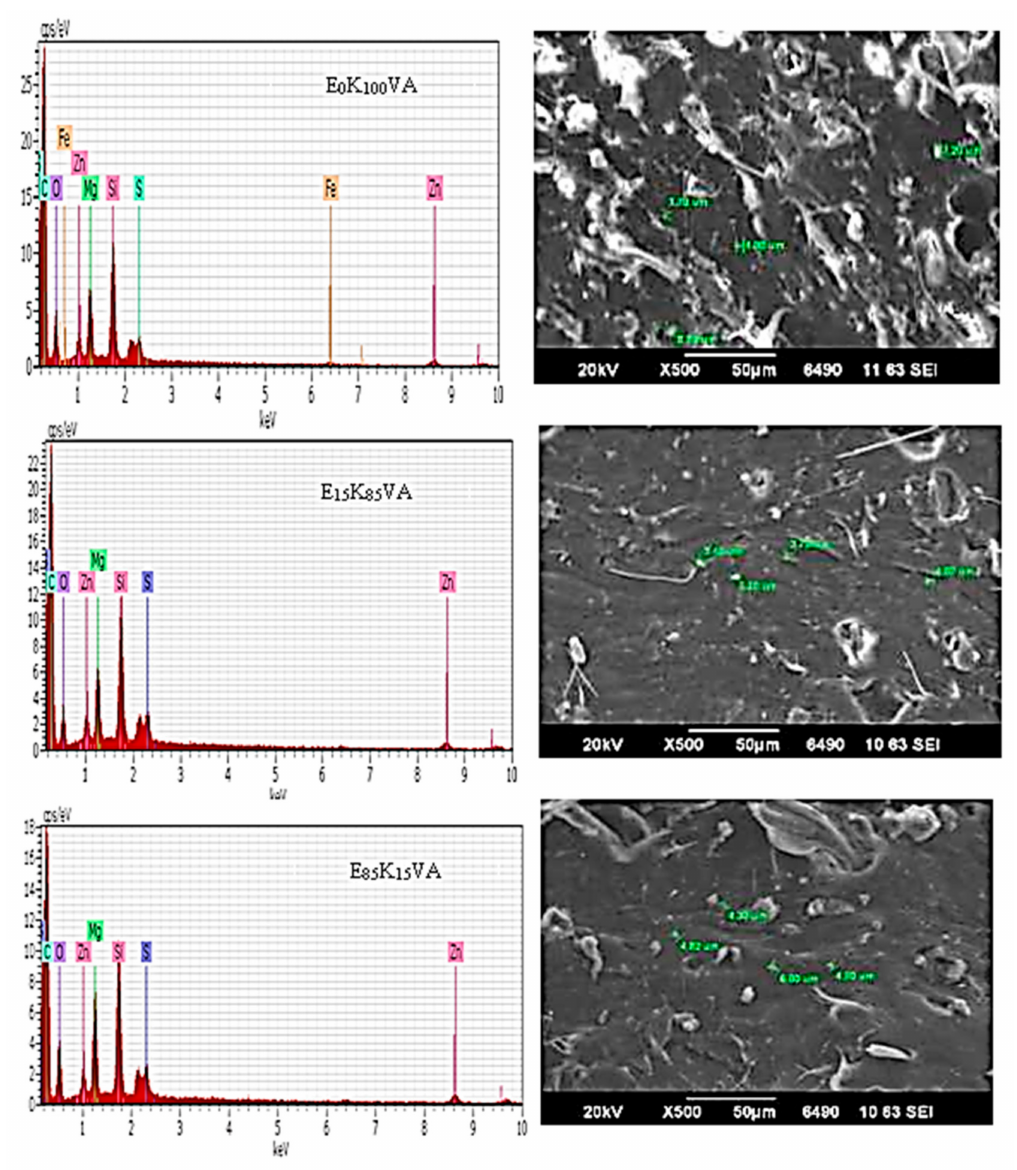
Figure 4. EDS spectra and SEM images of some samples of phase-2